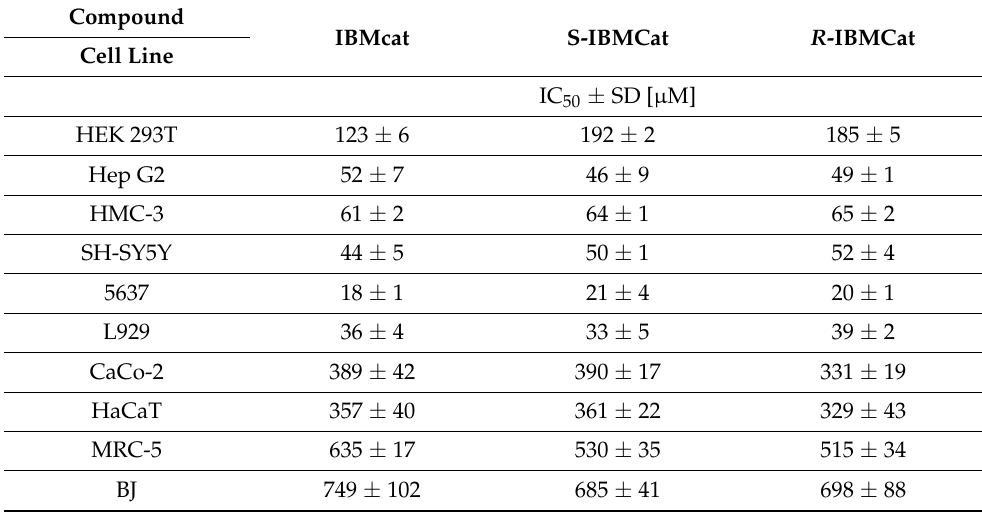
Table 2. Evaluation of in vitro cytotoxicity of 4-isobutylmethcathinone (IBMCat) and its enantiomers after 72 h of incubation with individual cell lines. IC 50 —half maximal inhibitory concentration, i.e., a concentration of a compound required to achieve a 50% reduction in cell viability; SD—standard deviation (from four